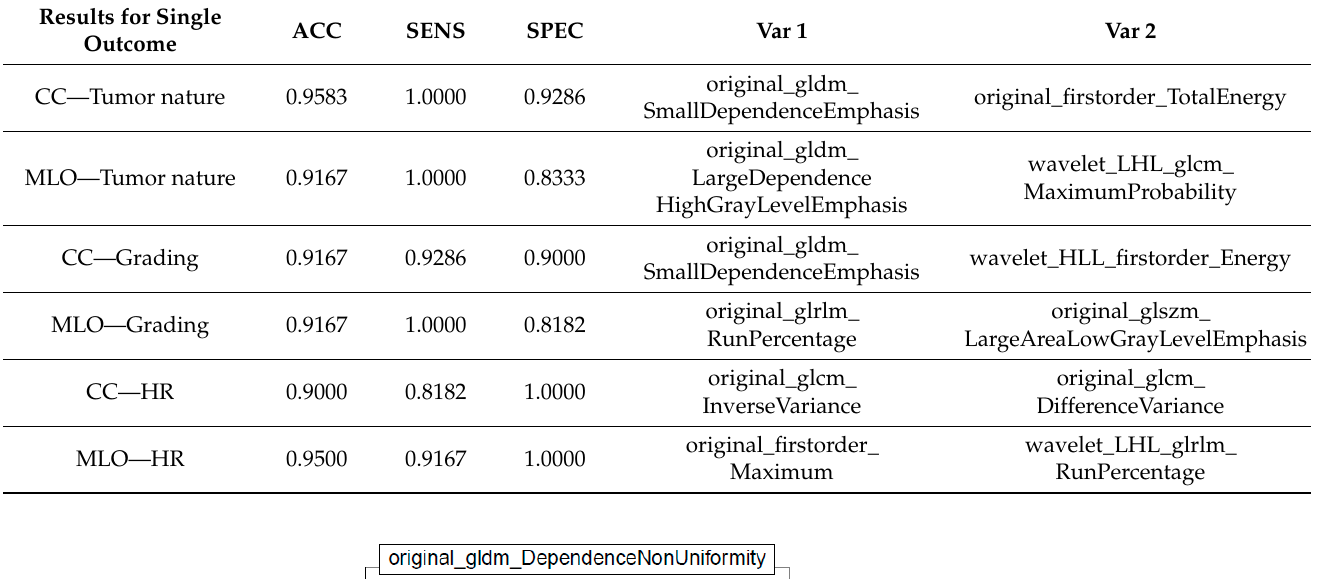
Table 5. Examples of results for logistic regression methods run using all possible combinations of two predictors.